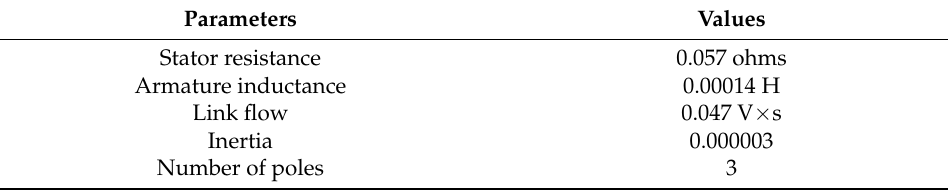
Table 1. Characteristic of the wind turbine.